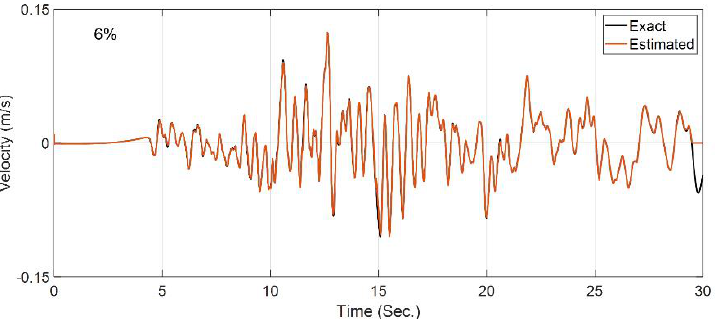
Figure 10. Comparison between the true incident motion and the estimated incident motion in Case Study 3.